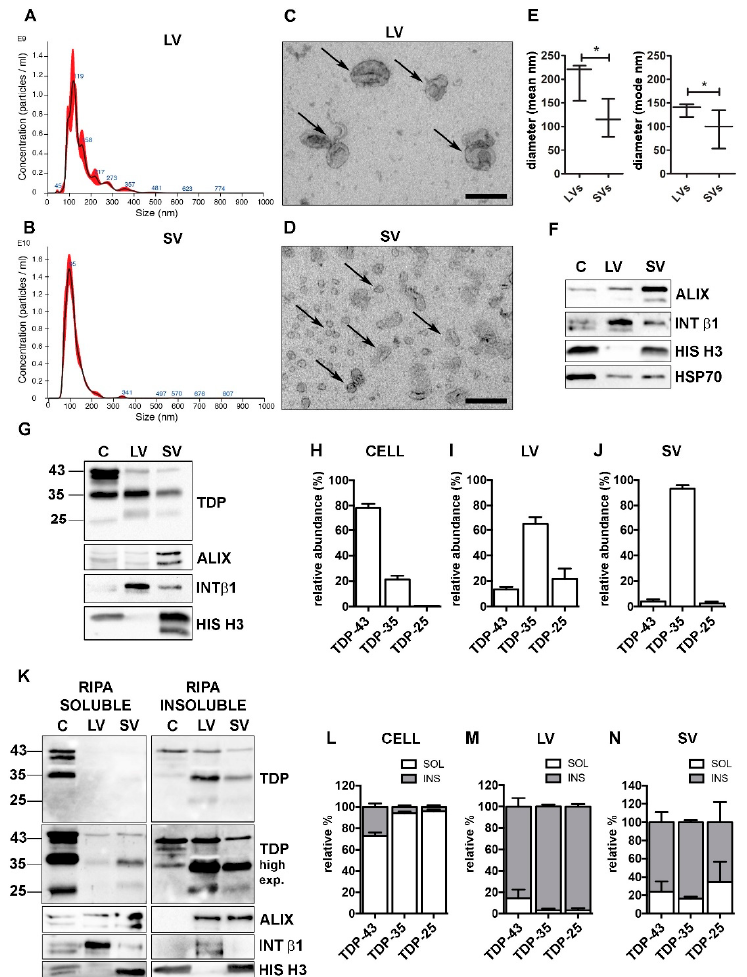
Figure 1. TDP-43 species were differently distributed in cells, LVs and SVs. ( A , B ) Representative nanoparticle-tracking analysis (NTA) distribution of LVs ( A ) and SVs ( B ) extracted from NSC-34 cells. ( A , B ) x -axis = vesicles dimension, expressed in nm; y -axis = vesicles concentration, expressed as number of particles/mL. ( C , D ) Representative transmission electron microscopy (TEM) of NSC- 34 cells-derived LVs ( C ) and SVs ( D ). Scale bar: 200 nm. ( E ) The graph represents the mean (left graph) and the mode (right graph) size ± SD of LVs (200.9 ± 40.7 nm; 136.1 ± 14.1 nm, respectively) and SVs (117.2 ± 40.3 nm; 96.0 ± 40.5 nm, respectively) of n = 3 biological replicates analyzed by NTA (* p < 0.05, unpaired one-tailed t -test). ( F ) Representative WB analysis of EVs markers in NSC-34-derived LVs and SVs samples. ( G – J ) WB analysis of TDP-43, TDP-35 and TDP-25 in total (i.e., soluble + insoluble) RIPA-extracted proteins from NSC-34 cells (C), LVs and SVs released in basal conditions ( G ) and relative quantifications ( H – J ). The bar graphs represent the relative abundance of TDP-43, TDP-35 and TDP-25 in cells ( H ), LVs ( I ) and SVs ( J ), expressed as mean [(optical density of a single TDP-43 species/optical densities of all the immunoreactive TDP-43 species) × 100] ± SD of n = 3 biological replicates. ( K – N ) WB analyses of RIPA-soluble (left-panels) and RIPA-insoluble (right-panels) fractions of NSC-34 cells, LVs and SVs ( K ) and relative quantifications ( L–N ). The bar graphs represent the relative abundance of each TDP-43 species in the soluble or insoluble fraction of cells ( L ), LVs ( M ) and SVs ( N ), expressed as [(optical density of soluble or insoluble/optical densities of soluble + insoluble TDP) × 100] ± SD of n = 3 biological replicates. ( L ) Cells: TDP-43, 72.8 ± 5.4% soluble; TDP-35, 94.3 ± 2.4% soluble; TDP-25, 96.0 ± 2.7% soluble. ( M ) LVs: TDP-43, 85.6 ± 13.8% insoluble; TDP-35, 96.9 ± 3.0% insoluble; TDP-25, 96.9 ± 3.8% insoluble. ( N ) SVs: TDP-43, 76.0 ± 19.1% insoluble; TDP-35, 83.7 ± 3.8% insoluble; TDP-25, 65.4 ± 7.8%